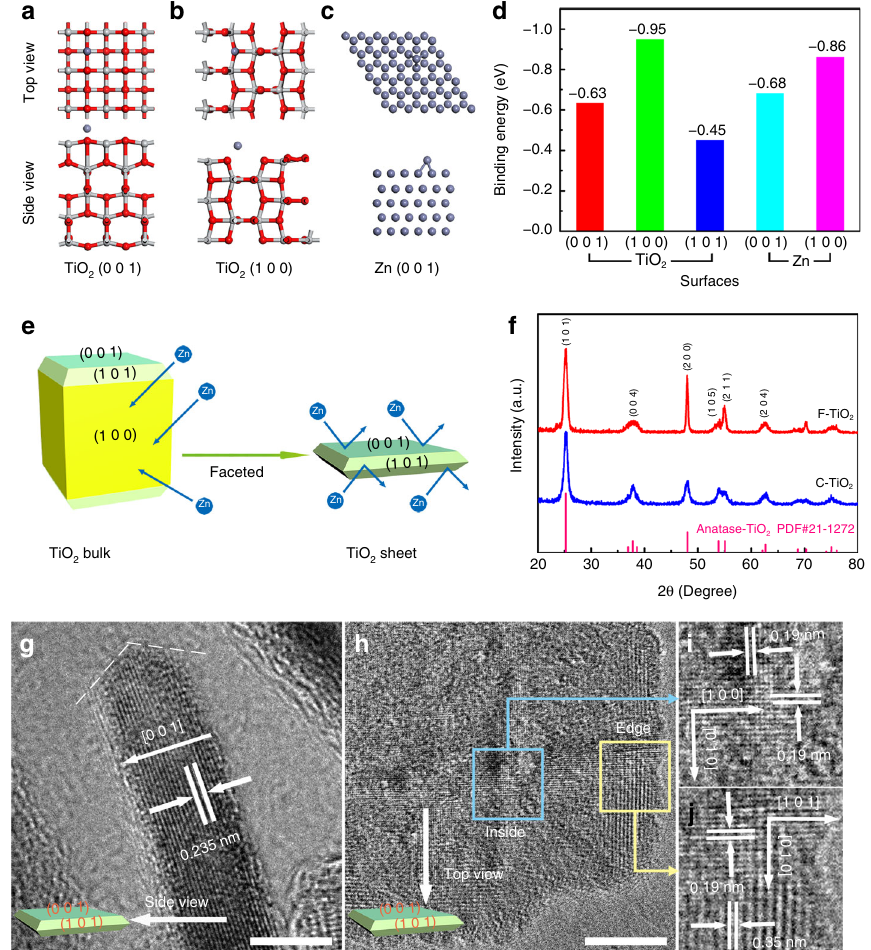
Fig. 1 Theoretical simulation and characterization of F-TiO 2 . Calculations models of Zn absorbed on a TiO 2 (0 0 1) facet, b TiO 2 (1 0 0) facet, and c Zn (0 0 1) facet. d Calculated binding energies of Zn atom with different facets. e Schematic illustration of the interaction between Zn and anatase TiO 2 with different exposed facets. f XRD patterns of F-TiO 2 and C-TiO 2 . g – j HRTEM images of F-TiO 2 . Scale bars: 5 nm.